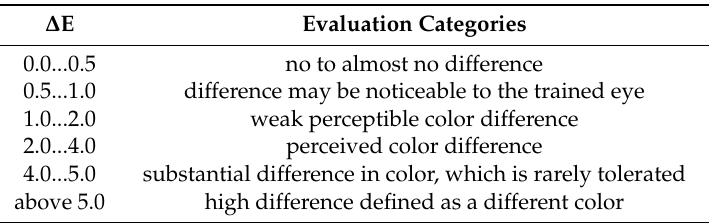
Table 1. Interpretation and evaluation of the ∆ E values ([43],